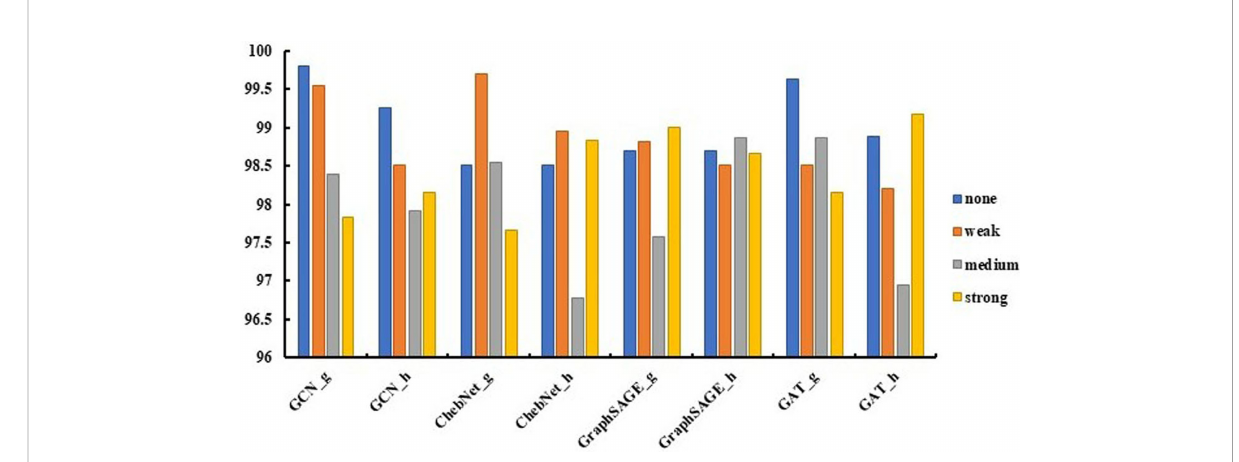
FIGURE 5 The accuracy of different GNN-based methods under different fi sh appetite